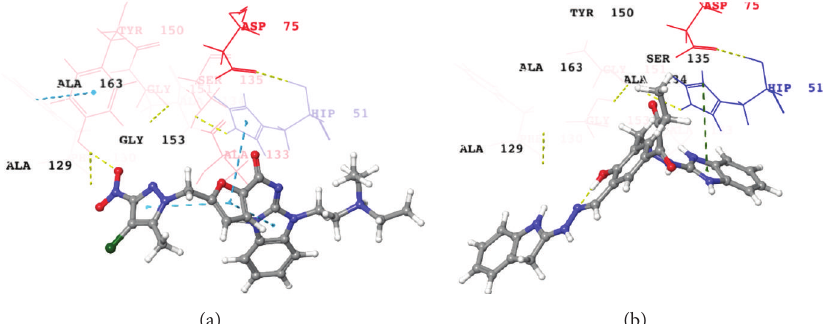
Figure 6: Interaction of ligands with mutated proteins: (a) Ligand 08 and (b) Ligand 19 .